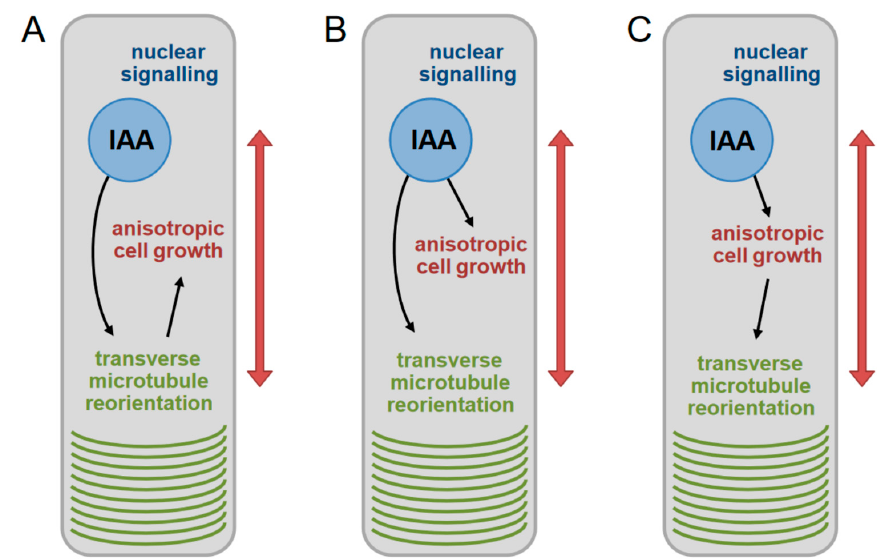
Figure 1. Hypotheses describing the relationship between auxin signaling, cell growth, and cortical microtubule reorientations in elongating hypocotyl cells. ( A ) Hypothesis A: Auxin triggers growth through reorienting microtubules into transverse arrays. The reorientation by auxin is a necessary part of the mechanism by which growth is activated. ( B ) Hypothesis B: Auxin triggers cell growth and the reorientation of microtubules by two parallel signaling mechanisms. Both these auxin signaling branches are activated in elongating cells of the hypocotyl. ( C ) Hypothesis C: Auxin triggers only cell growth, while the reorientation of microtubules is a downstream consequence of anisotropic growth and is by itself auxin independent.